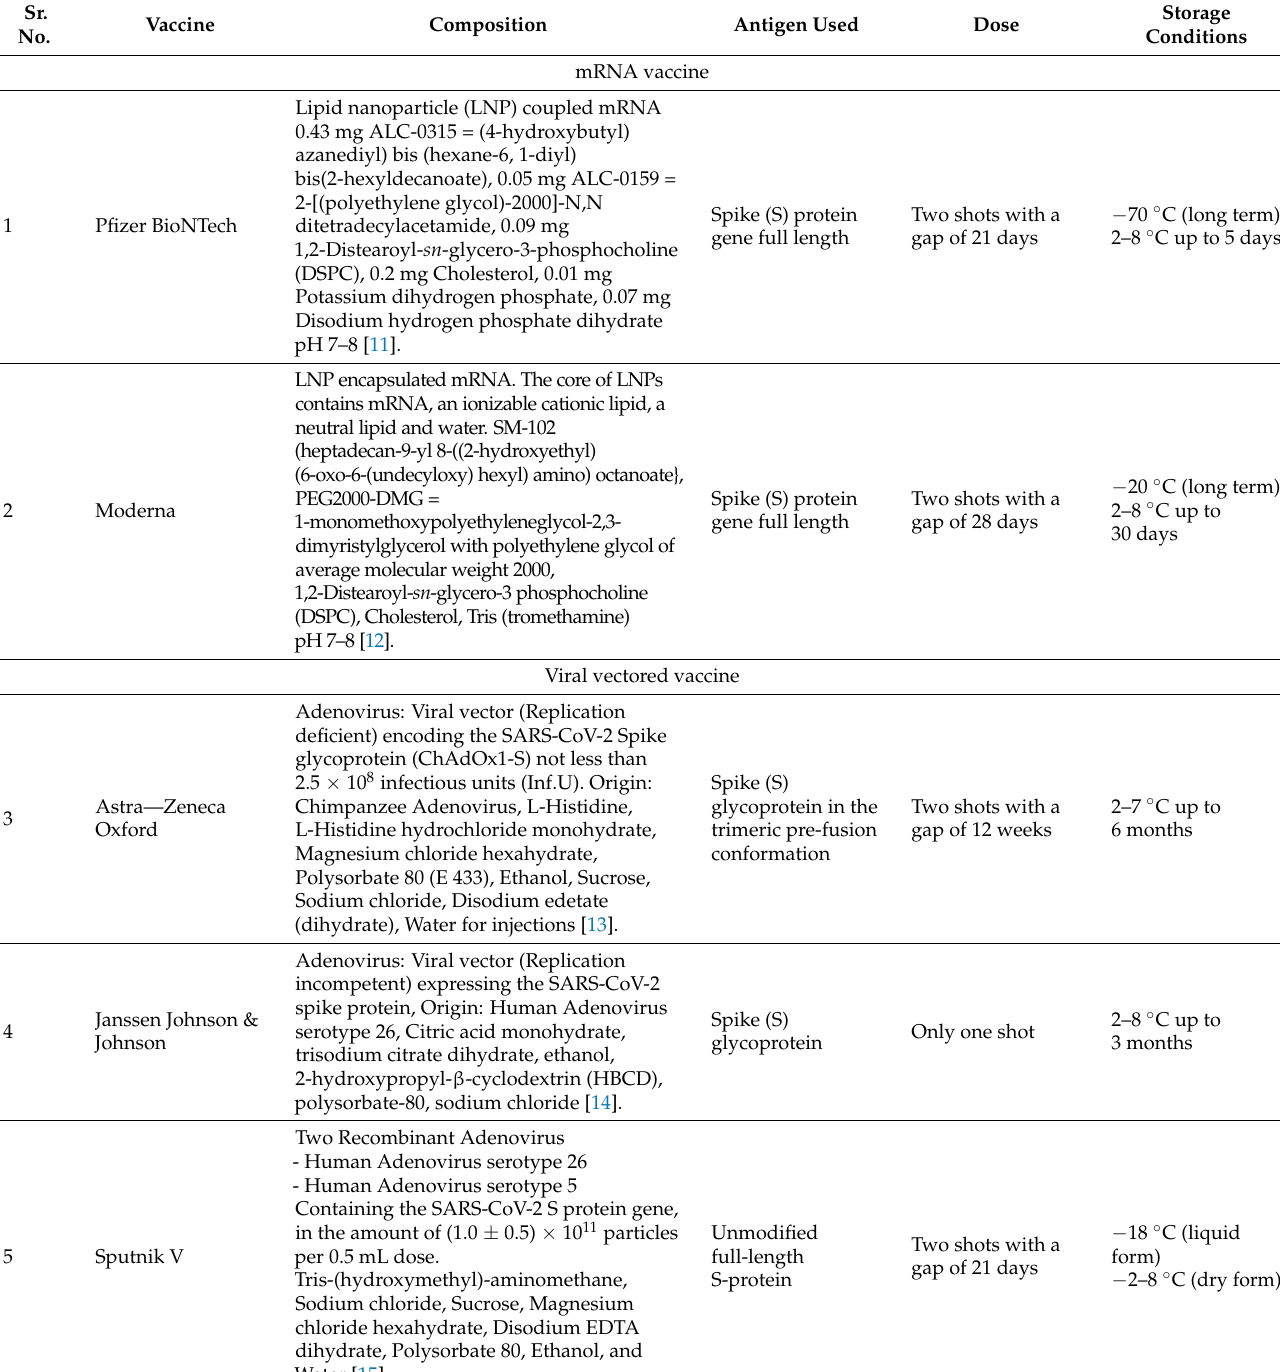
Table 2. SARS-CoV-2 vaccine candidate